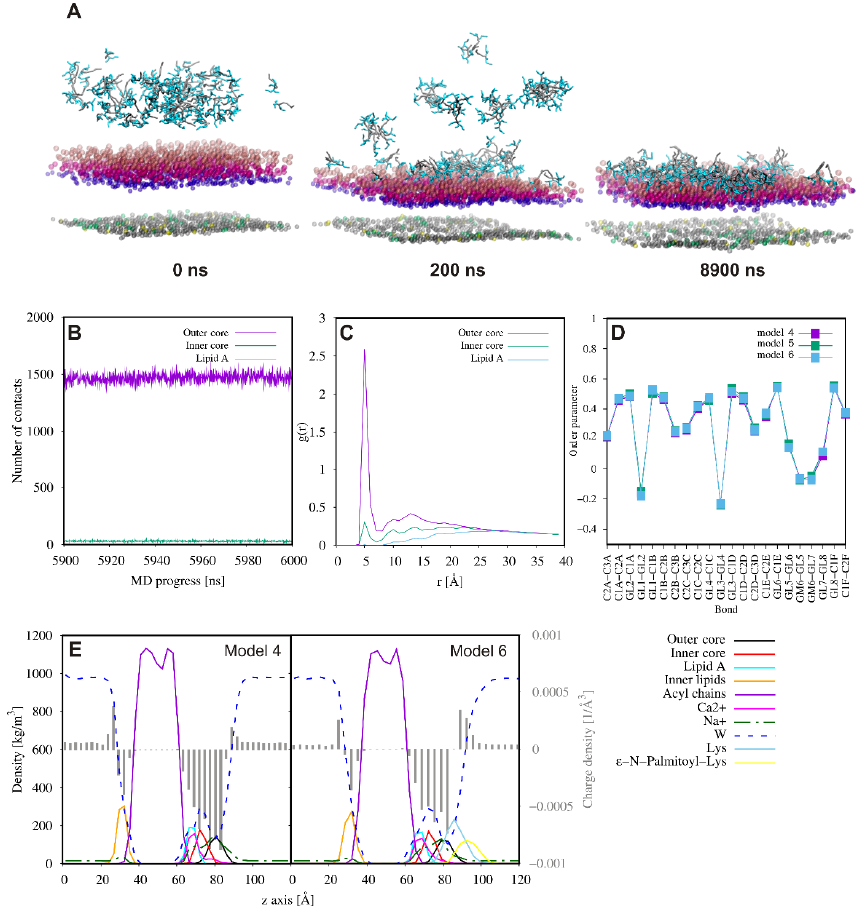
Figure 7. Representative snapshots from the Ra mutant rough chemotype lipopolysaccharide (RaLPS) / POPE / POPG / cardiolipin 2 (CDL2) binding CG MD simulations for KK(K C16 )KK-NH 2 . For clarity, only negatively charged beads of the membrane are displayed. Phosphate groups of the outer oligosaccharide core and Lipid A of RaLPS are colored pink and violet, respectively. The acid groups within the inner oligosaccharide domain of RaLPS are in magenta. Phosphate groups of the inner POPE, POPG, and CDL2 are gray, yellow and green, respectively. Fatty acid tails are in gray, while lysine residues are in cyan ( A ). The number of contacts ( < 5 Å) between lipopeptide molecules and three domains of the RaLPS ( B ). Radial distribution function of the negatively charged beads of RaLPS, i.e., phosphate groups in the outer core, carboxyl groups in the inner core and phosphate groups in the Lipid A around the lipopeptide molecules ( C ). Comparison of the lipid acyl chain order parameters of the RaLPS in systems without adding the lipopeptide and with the lipopeptide at two concentrations ( D ). Partial density and charge density profiles averaged over the last 100 ns of CG MD simulations ( E